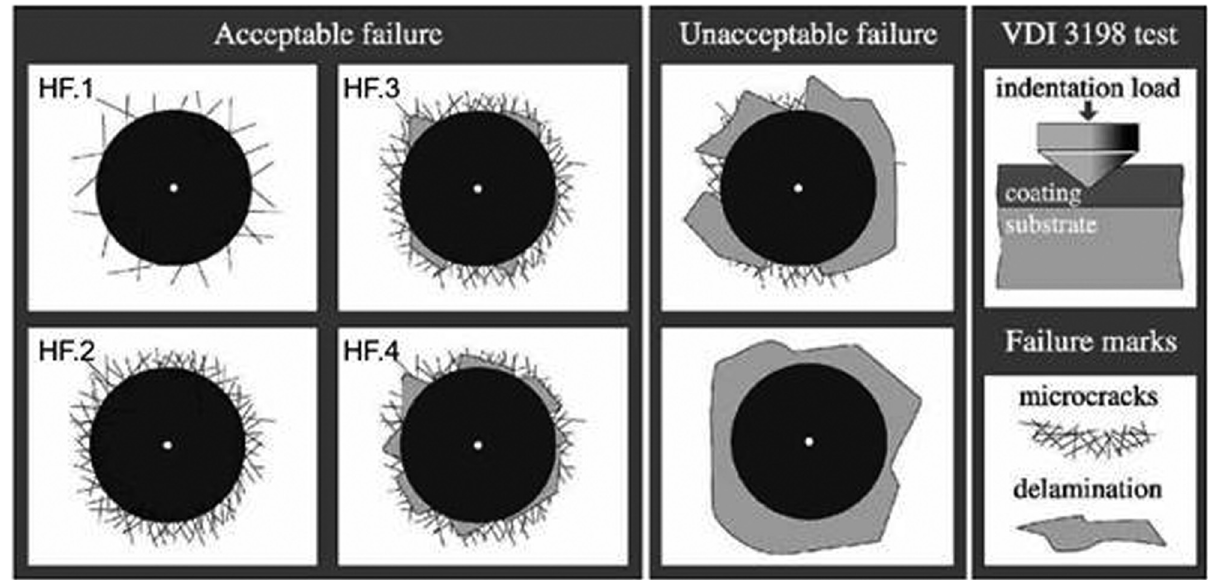
Figure 3: The principle of VDI 3198 indentation test [ 16 ]